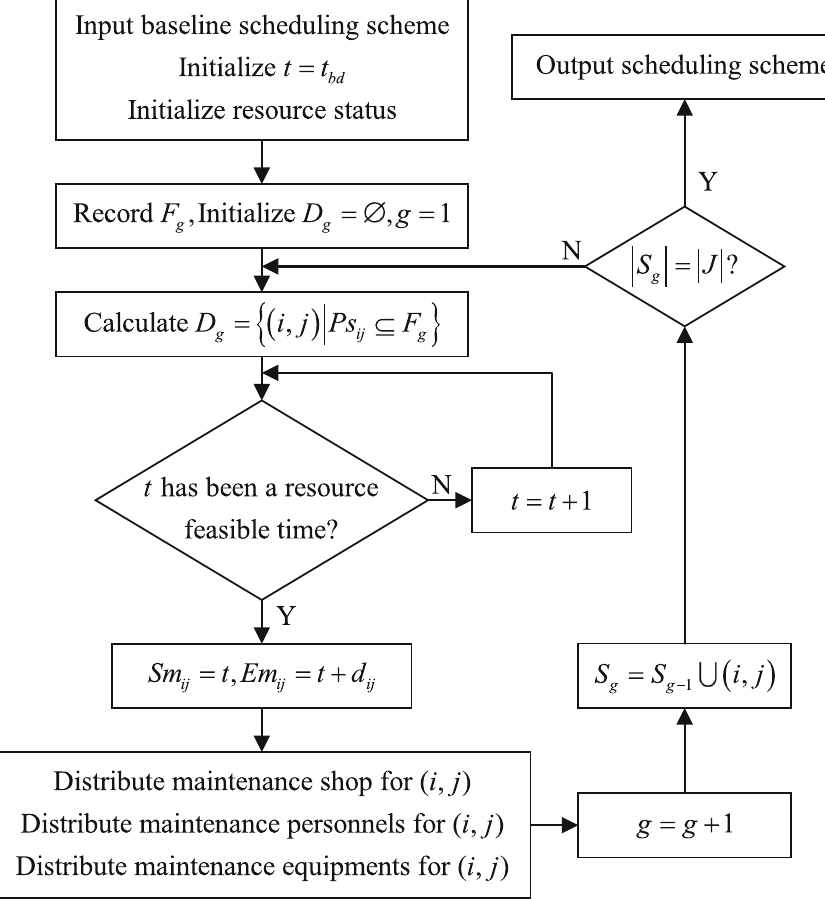
Fig. 6 Procedure for complete